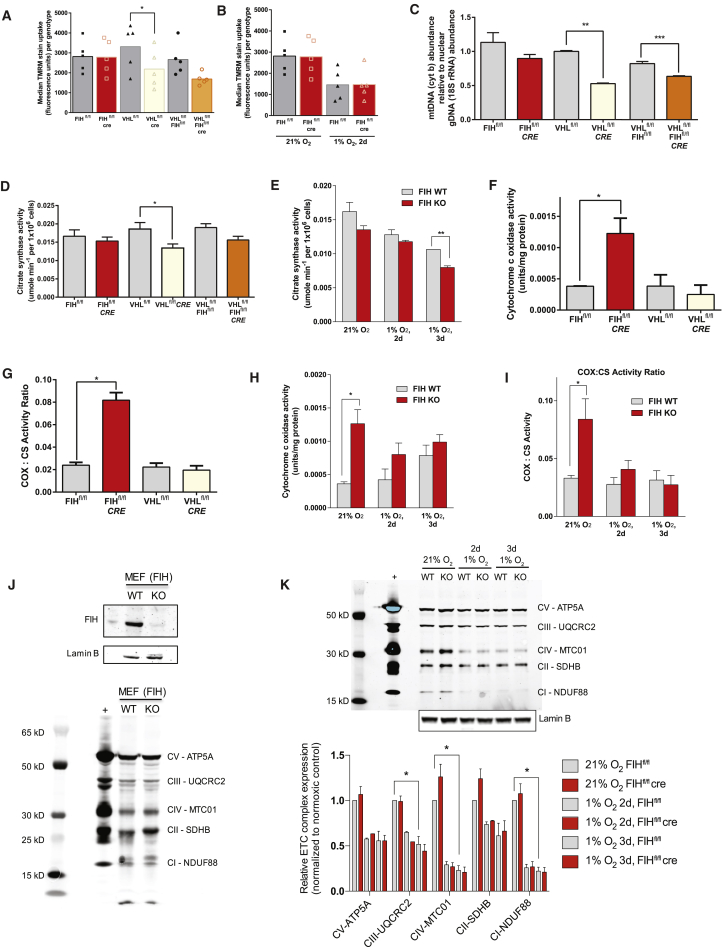
Differential Regulation of HIF Leads to Differential Regulation of Mitochondrial Parameters(A) Flow cytometry; histogram of cell count versus TMRM fluorescence, with shaded graph representing unstained controls. Three experiments were performed with two biological replicates each; this series of histograms is representative of one of these experiments.(B) Flow cytometry; histogram of cell count versus TMRM fluorescence, with shaded graph representing unstained controls. Three experiments were performed with two biological replicates each; this pair of histograms is representative of one of these experiments.(C) mtDNA abundance in indicated cells.(D) Citrate synthase activity measured in indicated cells.(E) Citrate synthase activity in FIH KO compared with control MEFs over prolonged exposure to hypoxia.(F) FIH, but not vHL KO cell lysates show higher mitochondrial cytochrome c oxidase activity (p = 0.049) than control MEFs.(G) Cytochrome oxidase activity of FIH KO MEFs normalized to citrate synthase activity.(H) FIH KO MEFs have higher cytochrome oxidase activity than control cells in atmospheric oxygen, but this effect is blunted over hypoxic exposure.(I) The trends described in (H) persist even when the cytochrome oxidase activity of FIH KO and control MEFs is normalized to citrate synthase activity levels.(J) Western blot of control versus FIH KO MEFs with lamin B as a loading control and rat heart mitochondria as a positive control; demonstrates total electron transport chain complex content in MEF lysates.(K) Western blot of mitochondrial complex content in control versus FIH KO MEFs, with progressive hypoxic exposure.∗p < 0.05, ∗∗p < 0.01, ∗∗∗p < 0.001. Data are represented as means ± SEM. For pairwise comparisons (A and B), a two-tailed Student's t test was used. For multiple comparisons (C, D, F, and G), a one-way ANOVA was used. For grouped data (E, H, I, and K), a two-way ANOVA was used. n = 3 independent cell culture samples per genotype, unless otherwise specified.